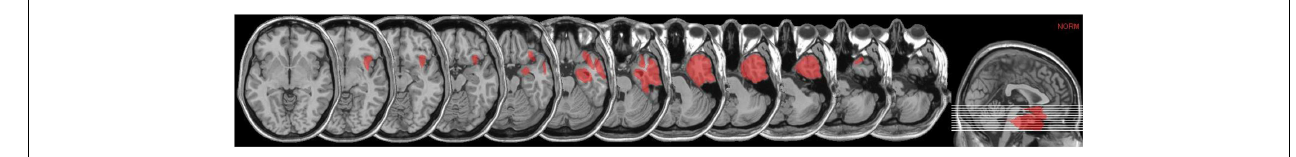
FIGURE 1 | Patient’s lesion reconstruction . See text for